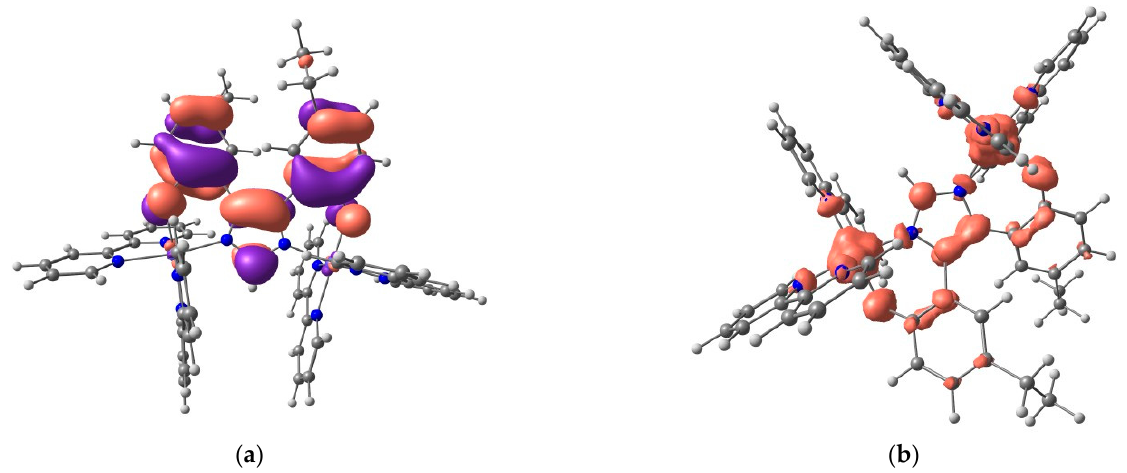
Figure 6. General view of ( a ) α -HOMO (0.03 isosurface level; EHOMO = − 0.1976 a.u.) and ( b ) spin density (0.0065 isosurface level) in the cation [(bipy) 4 Ni 2 (L)] 2+ .